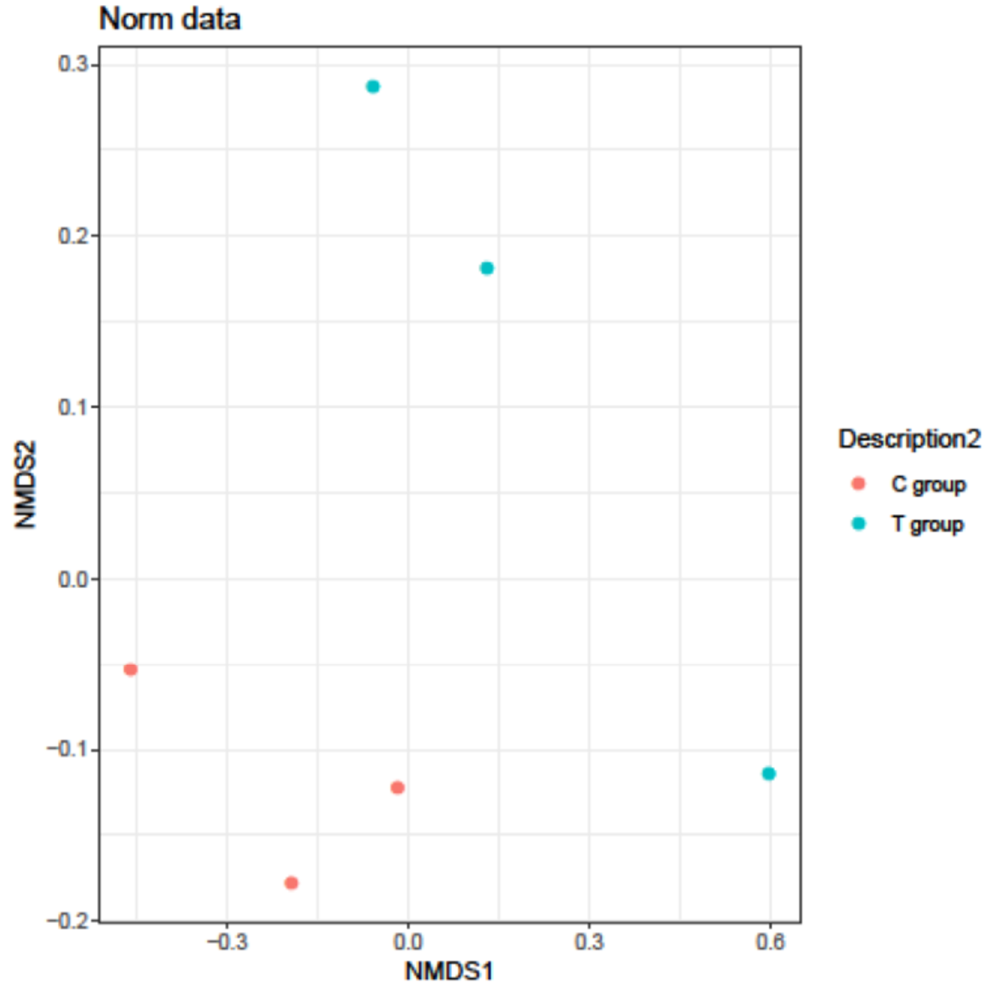
Figure 8. Non-metric multidimensional scaling analysis (NMDS). Representation of samples from C group and T group at six months; ( n = 3 in C group and n = 3 in T group).